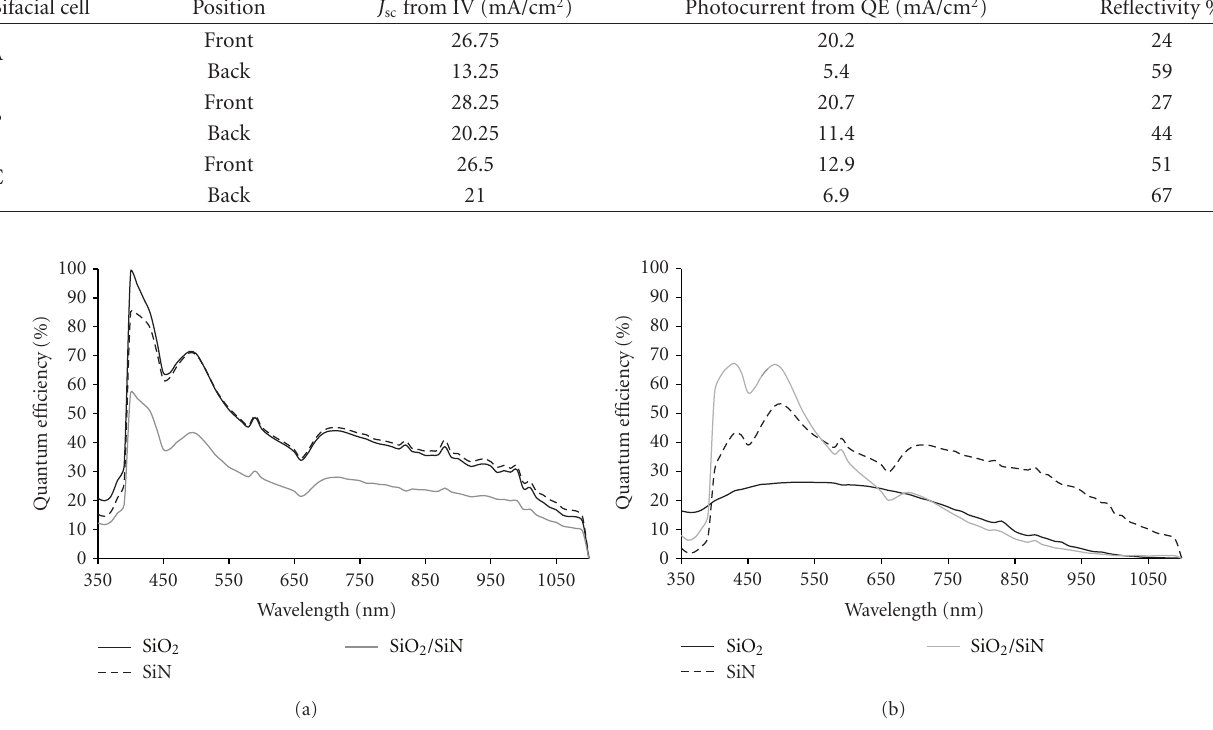
Figure 6: (a) Quantum e ffi ciency for front illumination. (b) Quantum e ffi ciency for back